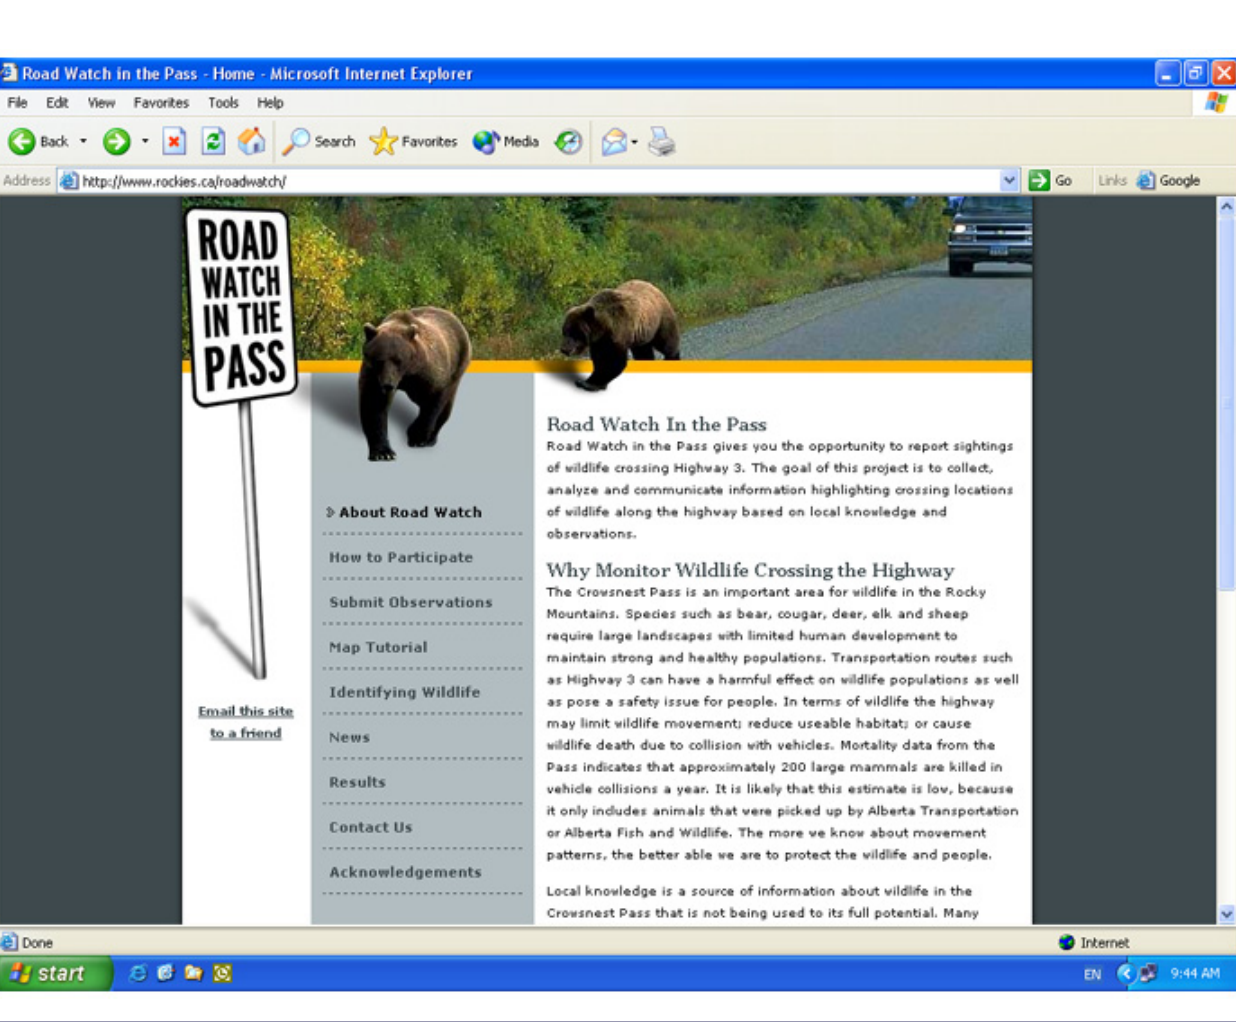
Fig. 1. Road Watch website home